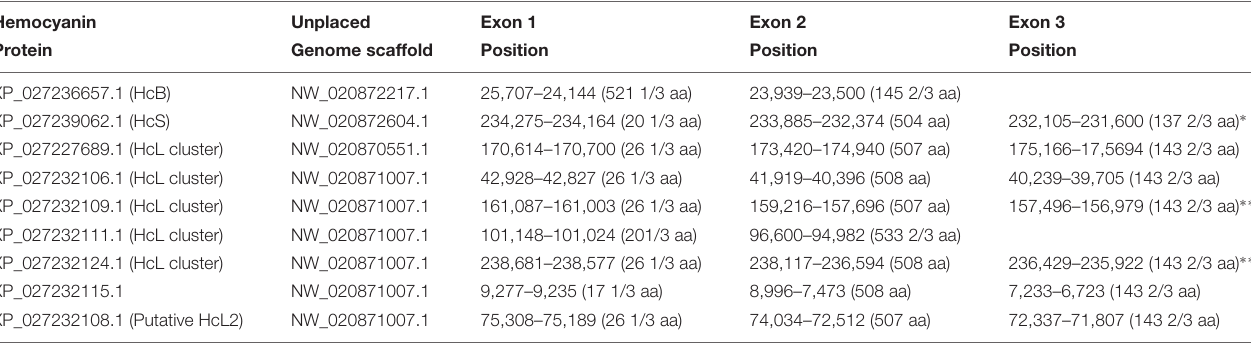
TABLE 2 | Exon positions for L. vannamei hemocyanins identified through LC-MS/MS and their respective positions on unplaced genome scaffolds from the reference genome assembly ASM378908v1 (Zhang et al., 2019). Hemocyanin Unplaced Exon 1 Exon 2 Protein